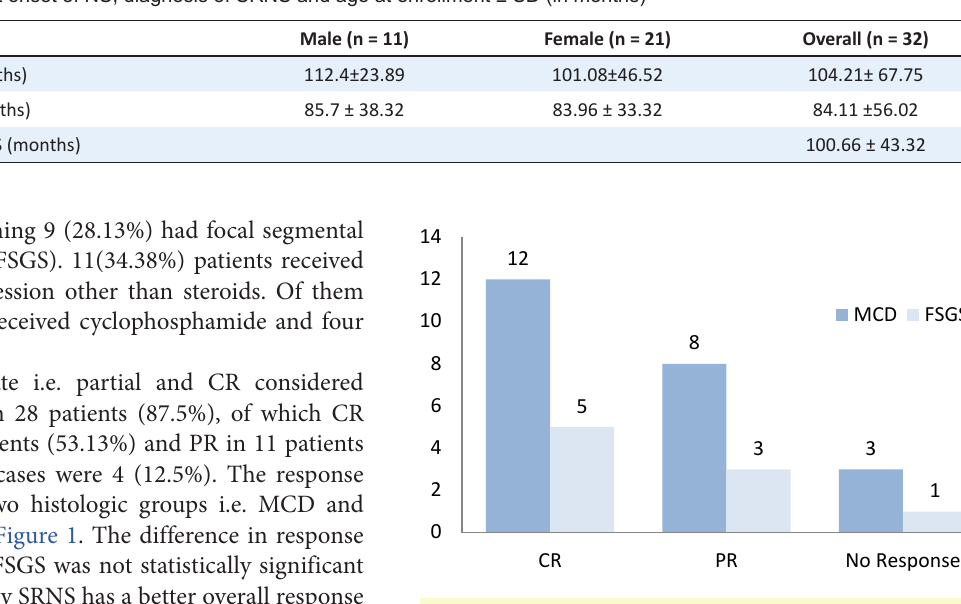
Figure 1. Response to therapy in two histologic groups (n).